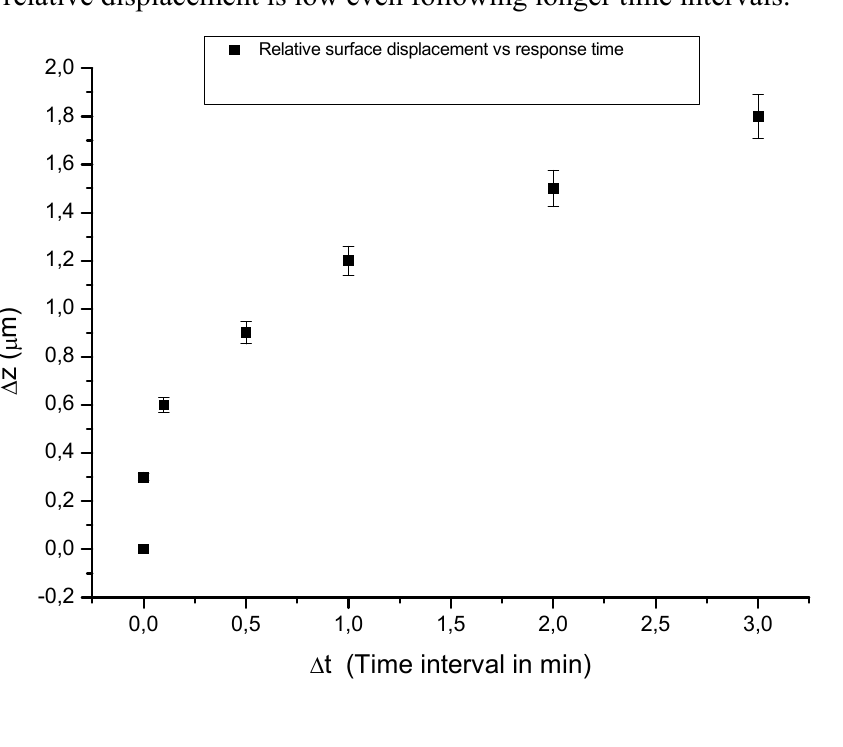
Figure 5. Graphs of the average displacement response during abrupt RH% changes, in samples of wood and ivory (a) Phase 3 detection of displacement requires pulsed exposure and short interval times and in (b) Phase 4 samples exhibit rapid displacement in Q- switched pulsed exposure and interval